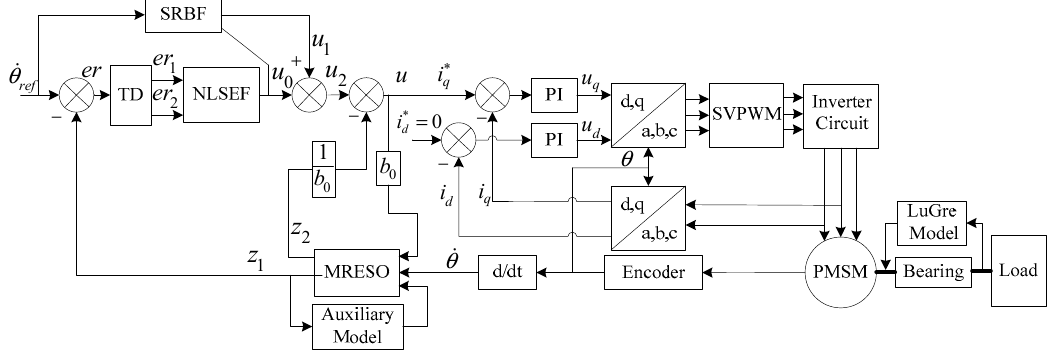
Figure 5. Block diagram of speed controller for PMSM.